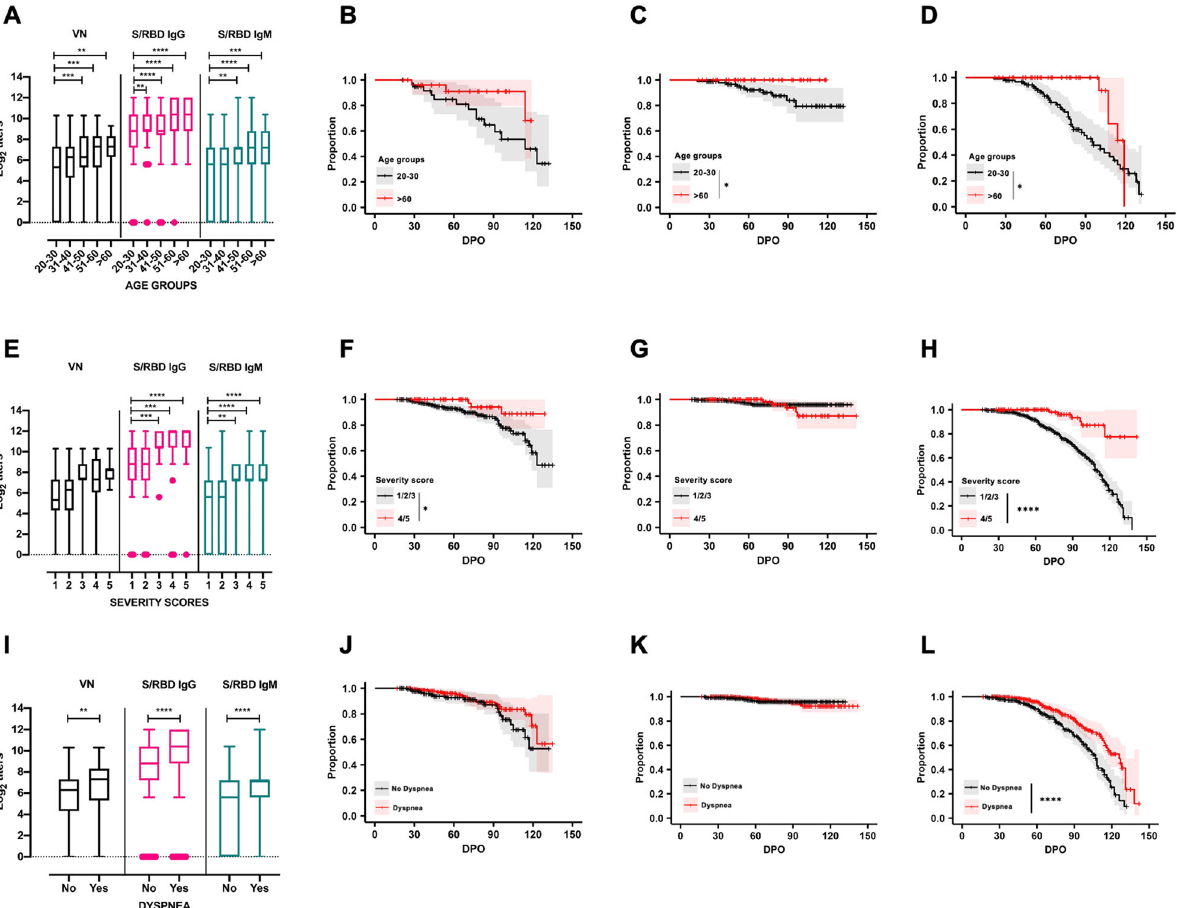
Fig. 3 Distribution of antibody titers against SARS-CoV-2 based on age, severity scores, and presence of dyspnea. These data represent samples collected from convalescent individuals ( n = 175) during the fi rst 140 days post-symptom onset (DPO). A Individuals <31 years of age have signi fi cantly lower IgG, IgM, and viral neutralizing antibody (VN) titers than those >40 years of age in this cohort (Ordinary one-way ANOVA, Tukey ’ s multiple comparison test; ** P < 0.01; *** P < 0.001; **** P < 0.0001). Survival analysis of ( B ) VN, ( C ) IgG, and ( D ) IgM antibody titers during the fi rst 140 DPO in convalescent individuals within the age groups of 20 – 30 ( n = 95 samples) and >60 ( n = 45 samples) (log-rank test, P > 0.05 for VN antibodies, * P < 0.05 for IgG and IgM). E Individuals with a severity score of 1 have signi fi cantly lower IgM and IgG titers than those above a score of 3 (Ordinary one-way ANOVA, Tukey ’ s multiple comparison test; ** P < 0.01; *** P < 0.001; **** P < 0.0001). Survival analysis of ( F ) VN, ( G ) IgG, and ( H ) IgM antibody titers in relation to severity scores grouped as mild (1/2/3) and severe (4/5) in convalescent individuals during the fi rst 140 DPO (log-rank test, * P < 0.05 for VN antibodies, P > 0.05 for IgG, **** P < 0.0001 for IgM). I Individuals with dyspnea had signi fi cantly higher VN, IgM, and IgG titers (unpaired t test,